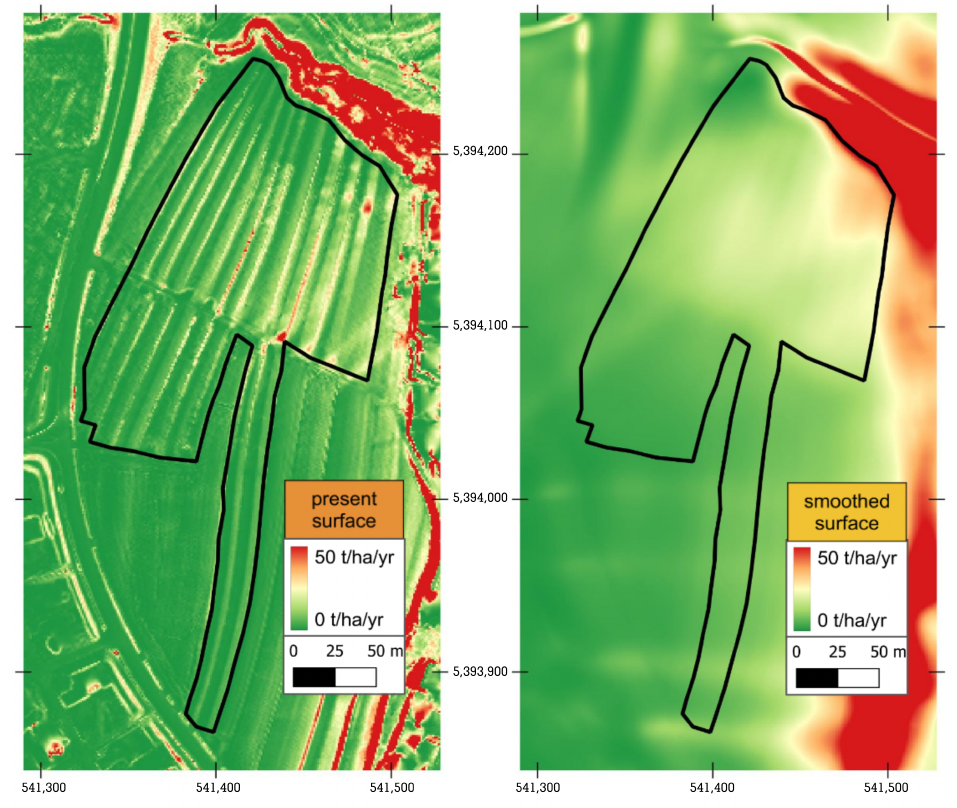
Figure 4. Maps of the two ( left : present surface, right : smoothed surface) erosion models for the study area. The red-to-green colour range shows the mean annual soil loss. The black line frames the cultural site within the plot Höfelbett